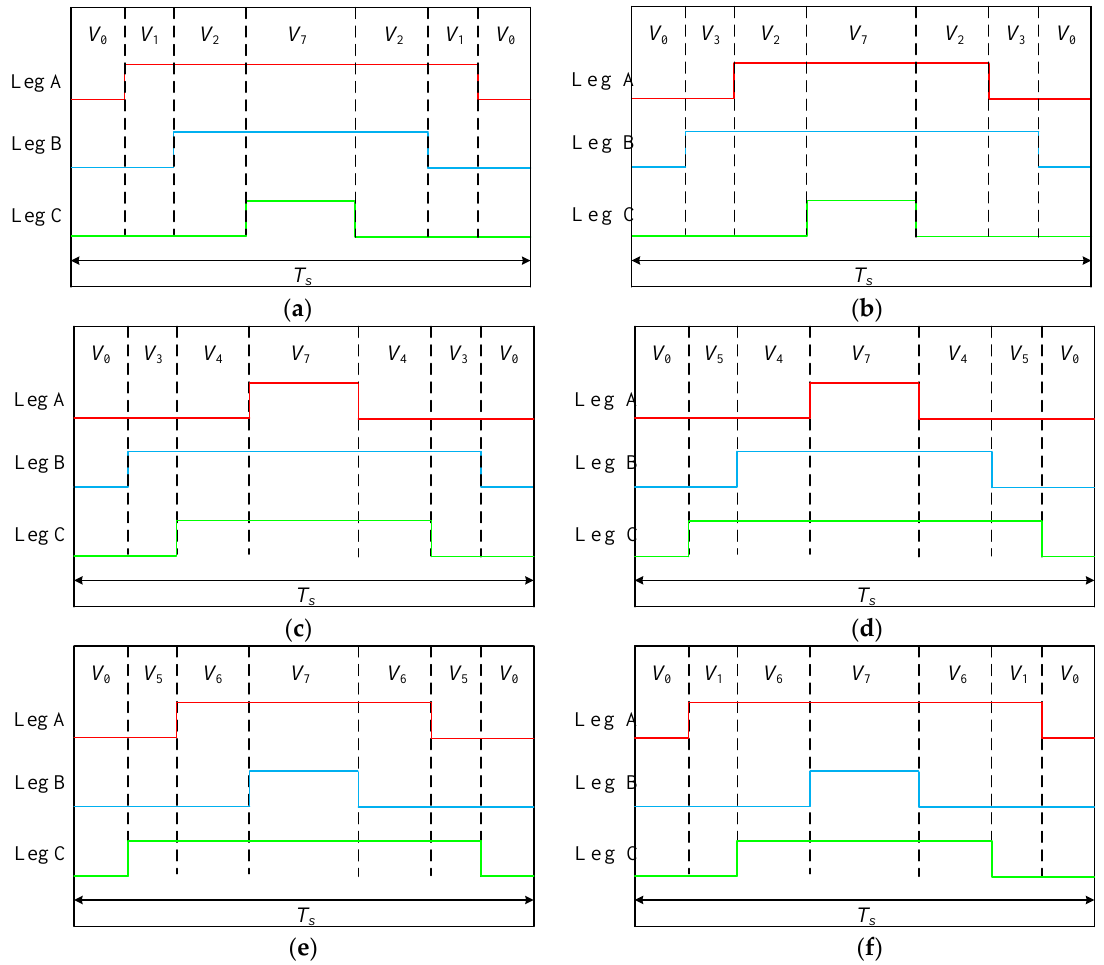
Figure 4. The sequence of vector actions for different vector combinations: ( a ) V 1 and V 2 ; ( b ) V 2 and V 3 ; ( c ) V 3 and V 4 ; ( d ) V 4 and V 5 ; ( e ) V 5 and V 6 ; ( f ) V 6 and V 1 .